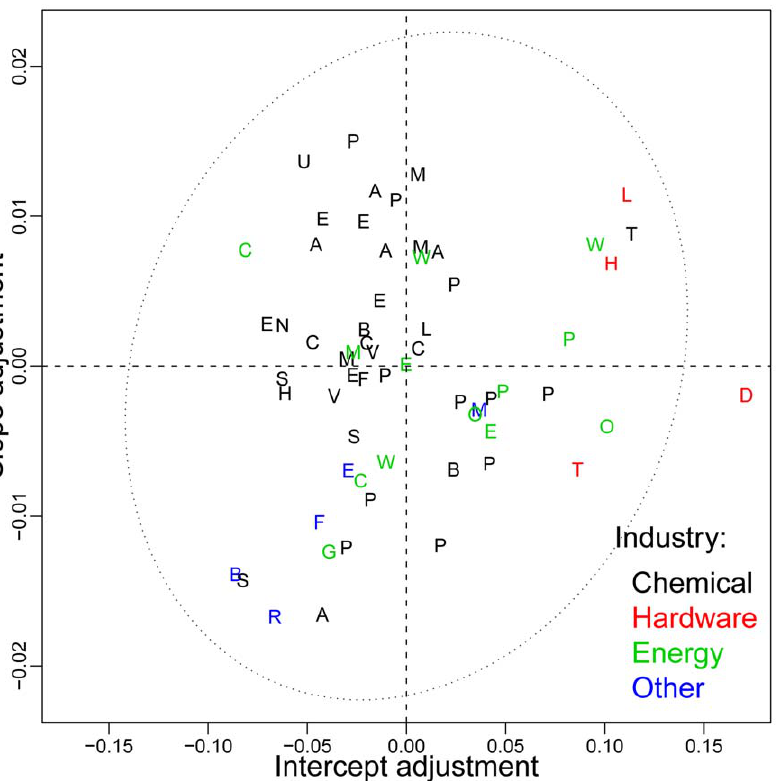
Figure 5. An illustration of how individual datasets deviate from the pooled data. The data-specific contribution to the slope, b d , is plotted against the data specific contribution to the intercept, a d , and compared to the ellipse of two standard deviation errors. The best forecasts are obtained for those found in the lower left quadrant, such as Beer, Sodium, RefinedCaneSugar, and Aluminum.